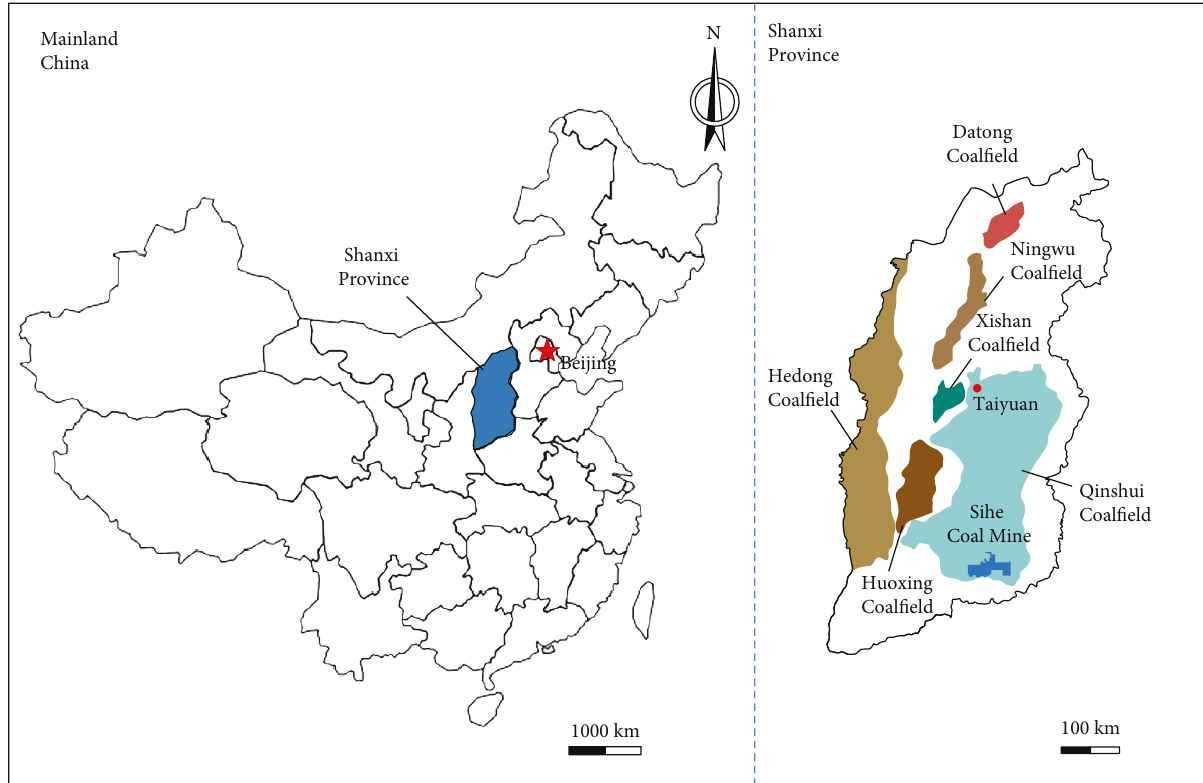
Figure 1: Location of the Sihe Coal